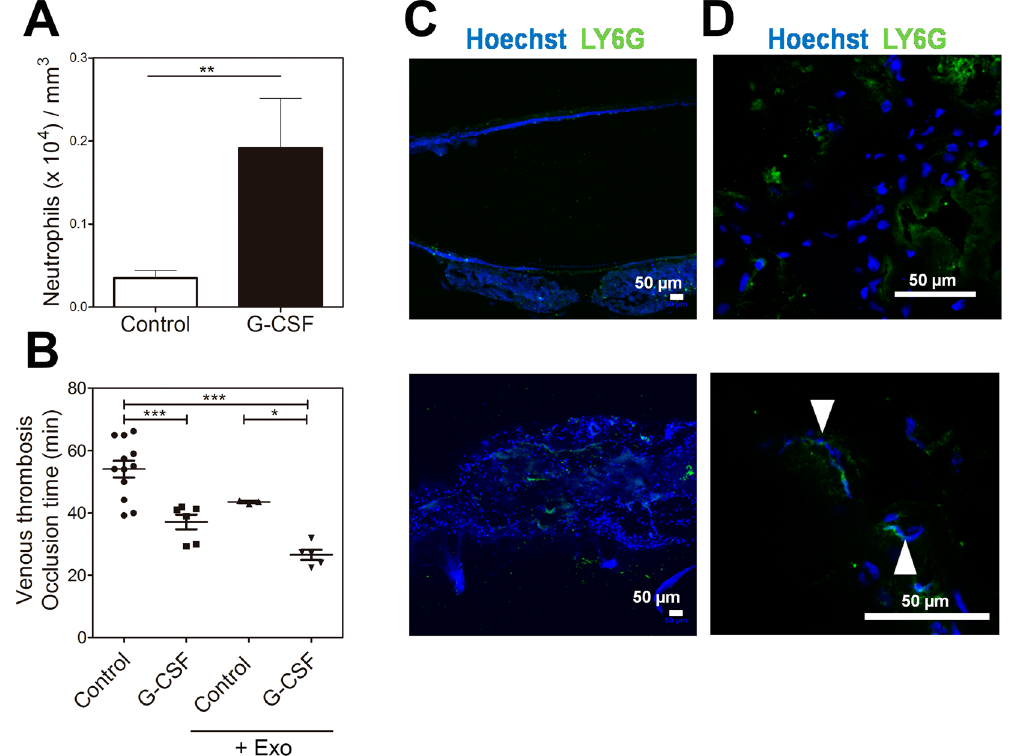
Figure 6. G-CSF and tumor-derived exosomes accelerate venous thrombosis in tumor-free mice. ( A ) Neutrophil counts in the peripheral blood of control (n = 5) and G-CSF-treated (n = 5) mice. ( B ) The venous thrombosis model was applied to control mice ( ● , n = 12), mice treated with G-CSF ( ■ , n = 6), control mice infused with 100 µ g of 4T1-derived exosomes ( ▲ , n = 3), or mice treated with G-CSF infused with 100 µ g of 4T1-derived exosomes ( ▼ , n = 5). The data represent the mean occlusion time after photochemical-induced vascular injury, with each data point representing one individual mouse. ** P < 0.01; *** P < 0.001; analysis of variance (ANOVA) with Tukey’s posttest. ( C ) Fluorescence microscopy analysis of cryosections of venous thrombi from control mice treated with exosomes (upper) and mice treated with G-CSF + exosomes (bottom). ( D ) Higher magnification of the venous thrombi from control mice treated with exosomes (upper) and mice treated with G-CSF + exosomes (bottom). The sections were stained with Ly6G (green) and Hoechst (blue). Extracellular DNA fibers are indicated by arrows. Bars = 50 μ